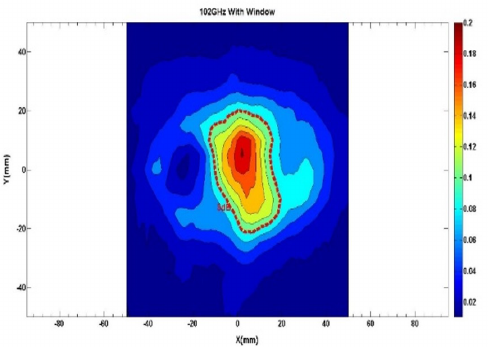
Figure 4. Beam radius inside the chamber with curvature win-